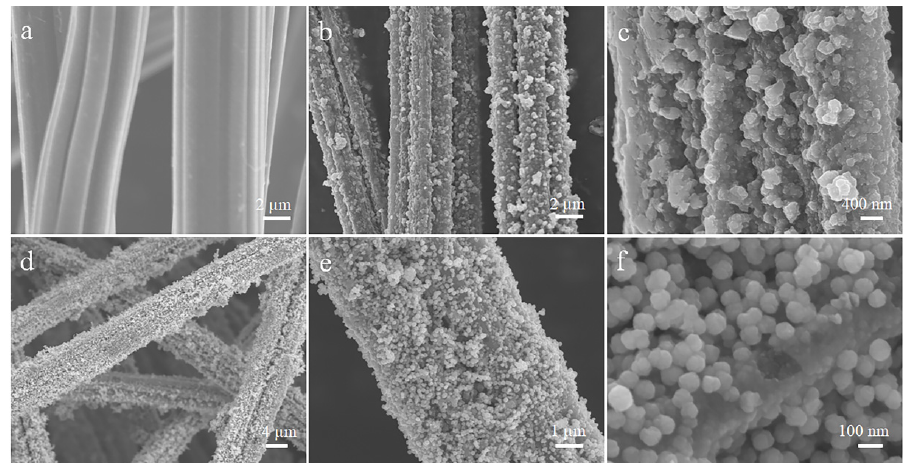
Figure 2. SEM diagram of samples: ( a ) carbon fiber (CF), ( b , c ) CF/SrTiO 3 , ( d – f ) CF/SrTiO 3 /CdS. The element distribution of CF/SrTiO 3 /CdS was studied by SEM mapping, as shown in Figure 3. SEM mapping was mainly used to study the element distribution over the surface of the CF/SrTiO 3 /CdS photocatalytic composite fibers, but carbon fibers were located in the center of the CF/SrTiO 3 /CdS core–shell structure. Therefore, as shown in Figure 3, relatively little carbon element was detected in the CF/SrTiO 3 /CdS fi- ber [31]. It can also be seen in Figure 3 that Ti, Sr, O, Cd, and S elements were uniformly distributed on the surface of the carbon fibers. Combined with Figures 1 and 2, it can be determined that the preparation of CF/SrTiO 3 /CdS was successful, and SrTiO 3 and CdS were evenly distributed on the carbon fibers.